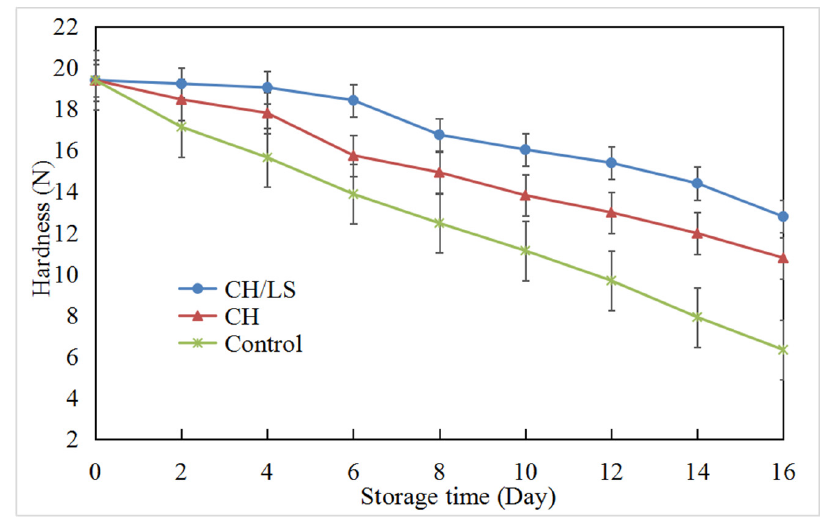
Figure 2. Hardness of grapes during preservation with different packaging films.